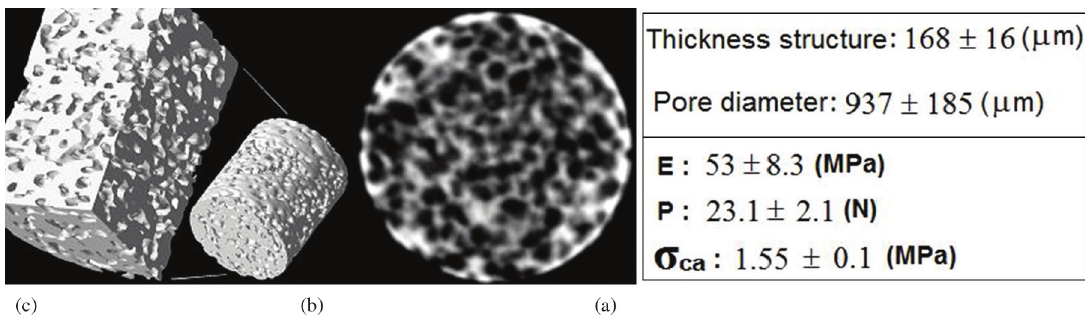
Figure 3. (a) 2D slice obtained using the Micro-CT. (b) 3D projection (this is a union of all the 2D slices). (c) Internal architecture of porous scaffold B. On left side of picture are the results of mean values of thickness and pore diameter obtained from Micro-CT and the results of mechanical compression test ( E, P and σ ca